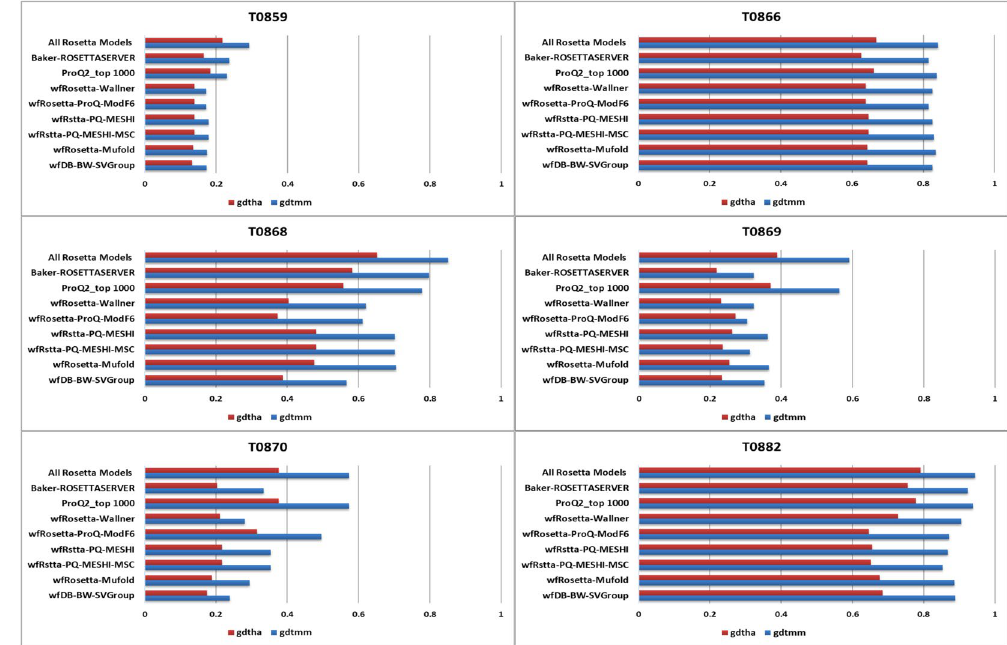
Figure 10. Bar plots show the down-selection process across the Rosetta-based pipelines for 6 targets using GDT_HA and GDT_MM. In each row, red bars represent best GDT_HA and blue bars represent best GDT_MM. GDT_MM is a Baker-lab specific metric, where the MAMMOTH alignment algorithm (MM = MAMMOTH) is used for the superposition (slight variations with respect to GDT_TS are based on alignment). Top row shows best GDT_HA (or MM) among the hundreds of thousands of models generated by Rosetta for that target. Next row shows the best GDT_HA (MM) among the best 5 selected by the BAKER- ROSETTASERVER; next row shows the best GDT_HA (MM) among the one thousand models selected by ProQ2; the remainder rows show the best GDT_HA (MM) among the best 5 selected by the Rosetta-based WeFold groups (one set of bars